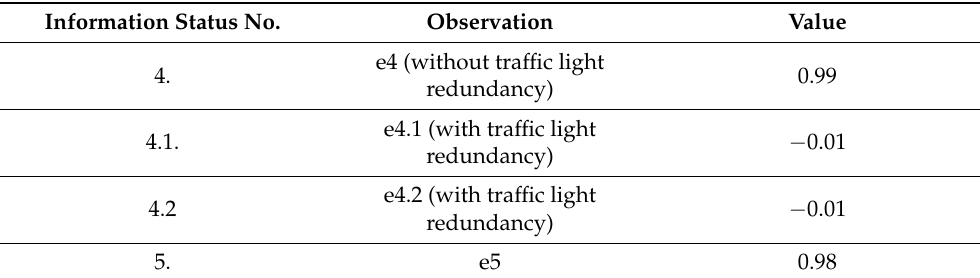
Table 2. The values achieved by two quality information stages for the case with and without doubled traffic lights and the assigned observations (the authors’ own study based on direct observations).